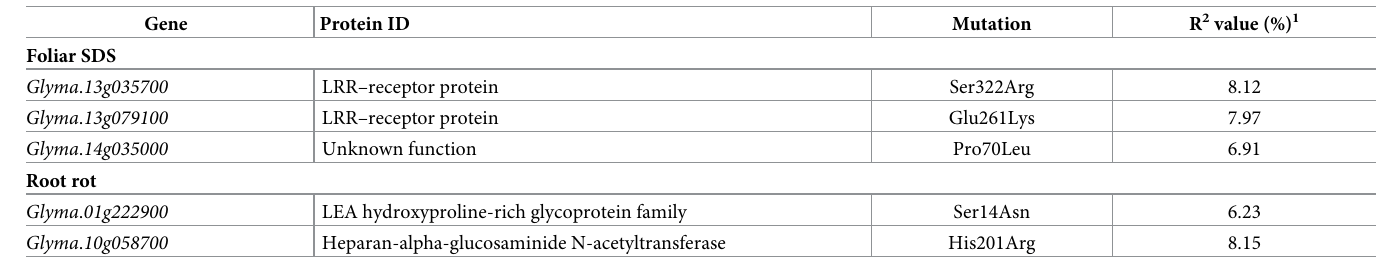
Table 3. Five nonsynonymous mutations that are mapped to candidate SDS resistance